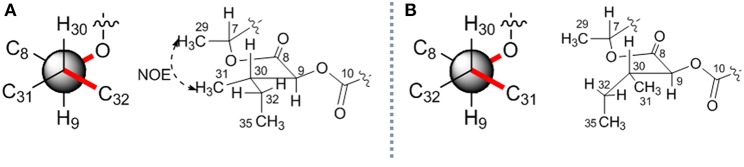
The relative stereochemistry of C-9 and C-30 in 7. Two possible relative structures (A,B).